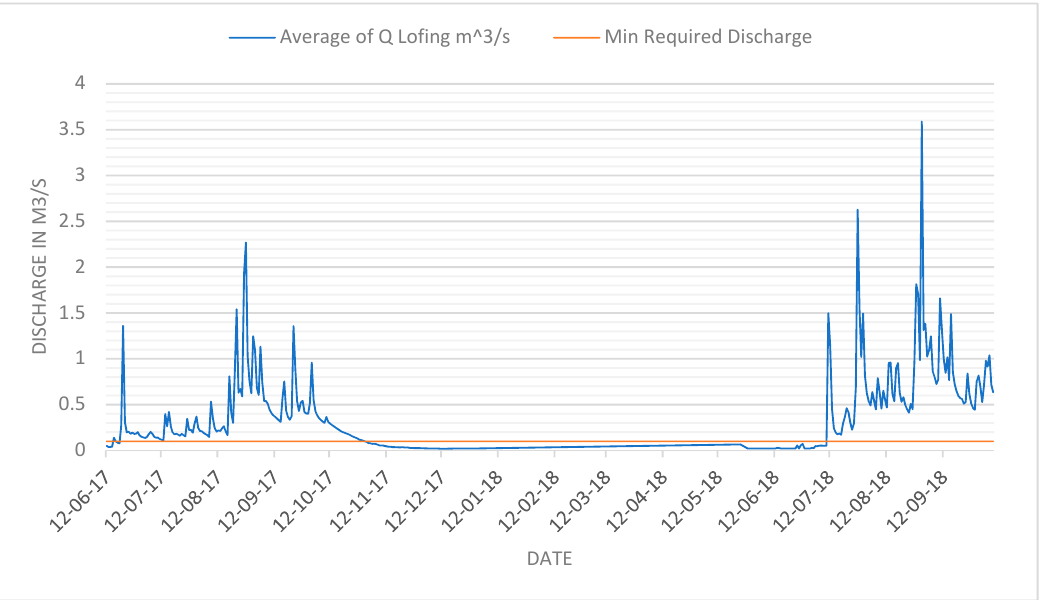
Figure A1. Comparison of the available discharge and irrigation water requirement for the 30 ha Lofing inland-valley.